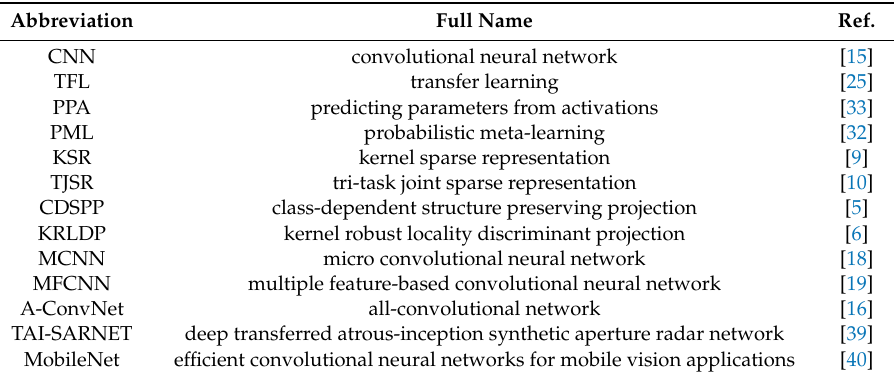
Table 4. Reference methods that are studied in this